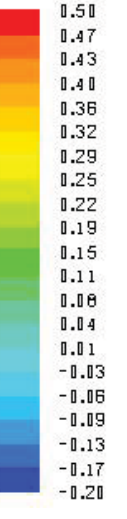
Figure 10: Radial velocity component (z) – cross section between the protrusions